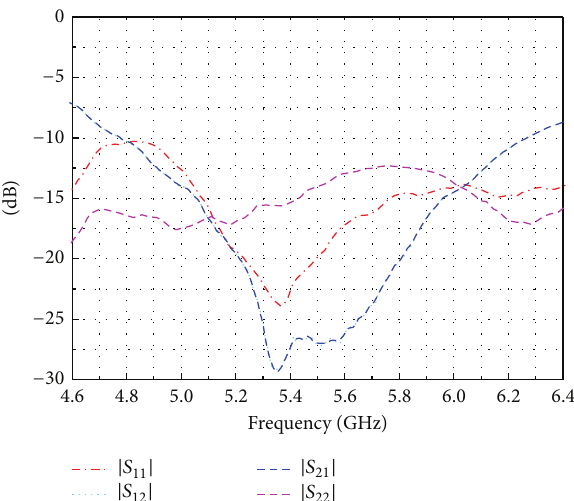
Figure 4: Measured 𝑆 -parameters